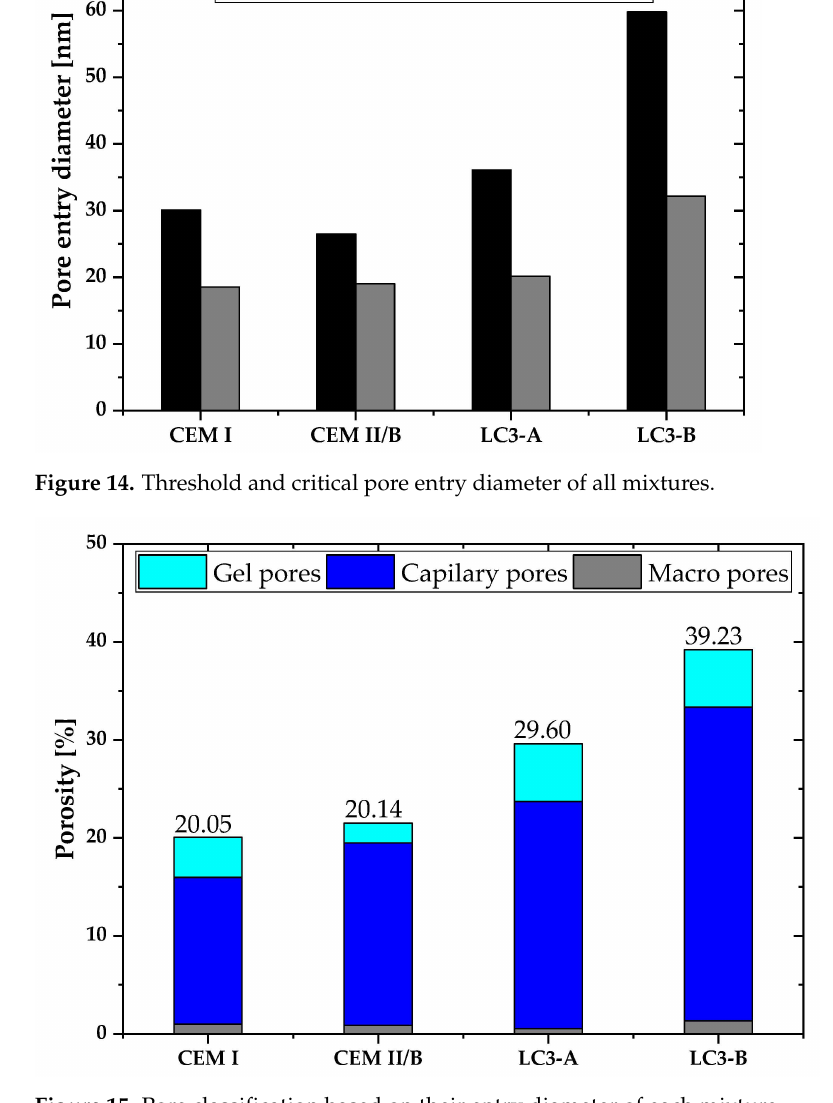
Figure 15. Pore classification based on their entry diameter of each